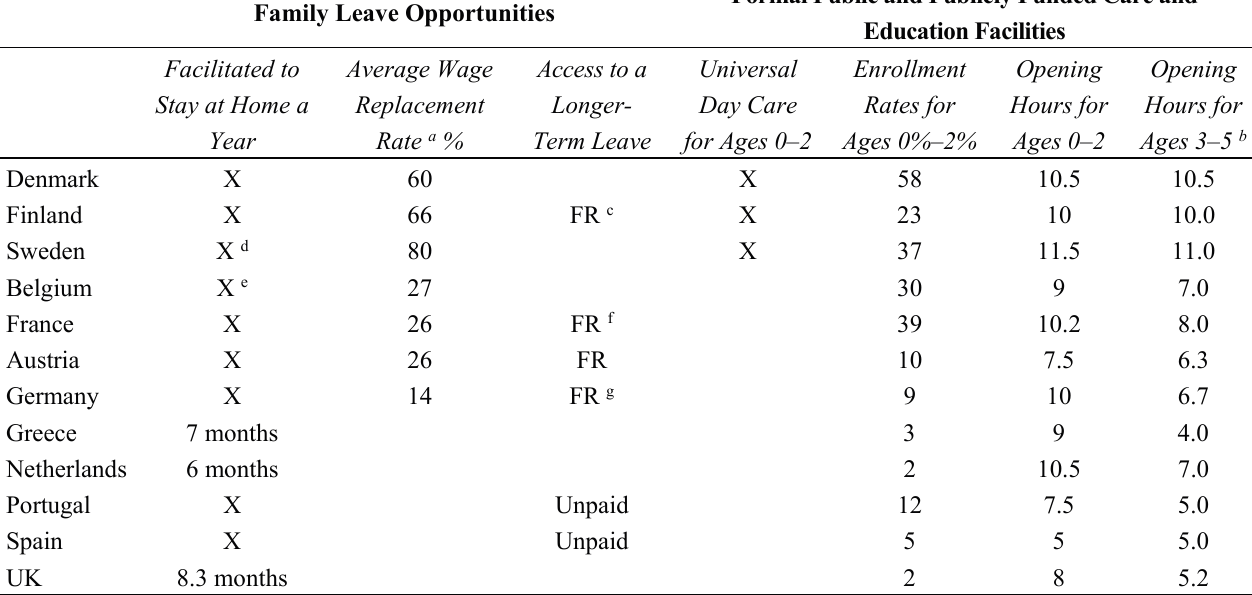
Table 1. Characteristics of childcare policies around the year